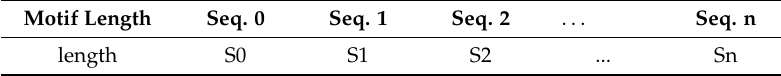
Table 2. The representation of an individual.